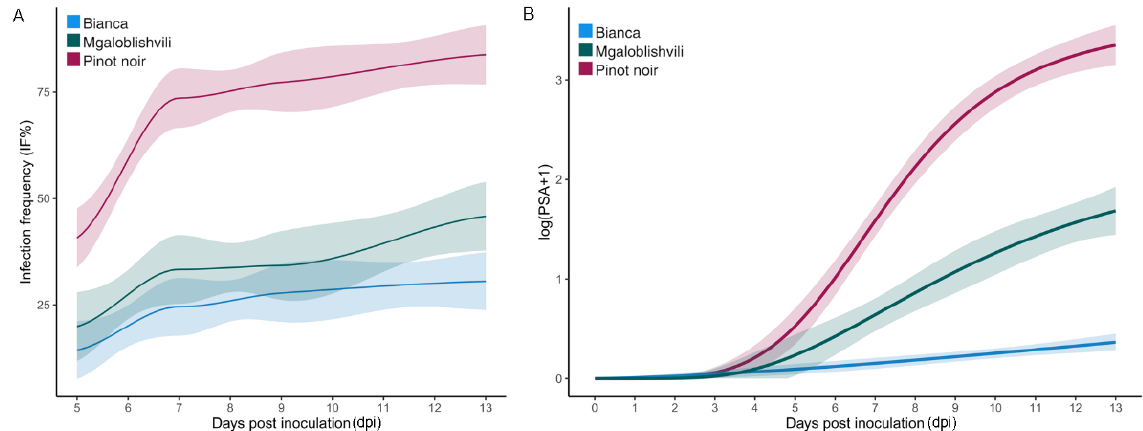
Figure 1. Fitted curves of IF ( A ) and log(PSA + 1) ( B ) values recorded on Bianca, Mgaloblishvili, and Pinot noir from 5 to 13 dpi by P. viticola isolates. IF lines were obtained through local polynomial regression fitting using loess() function in R, while PSA curves were obtained according to log-logistic regression model predictions. Light-colored ribbons show 95% confidence intervals for fitted curves. Table 2. Estimated parameters obtained for each curve (grapevine cultivar) with the log ‐ logistic model on transformed PSA values. Different letters within columns indicate the existence of signif ‐ icant differences among log(x + 1) transformed b (slope) and d (upper asymptote) values and e (t 50 ) values (expressed as dpi) ( p < 0.01). Values in brackets represents back ‐ transformed (y = e x + 1) values of d to the original scale (PSA %).